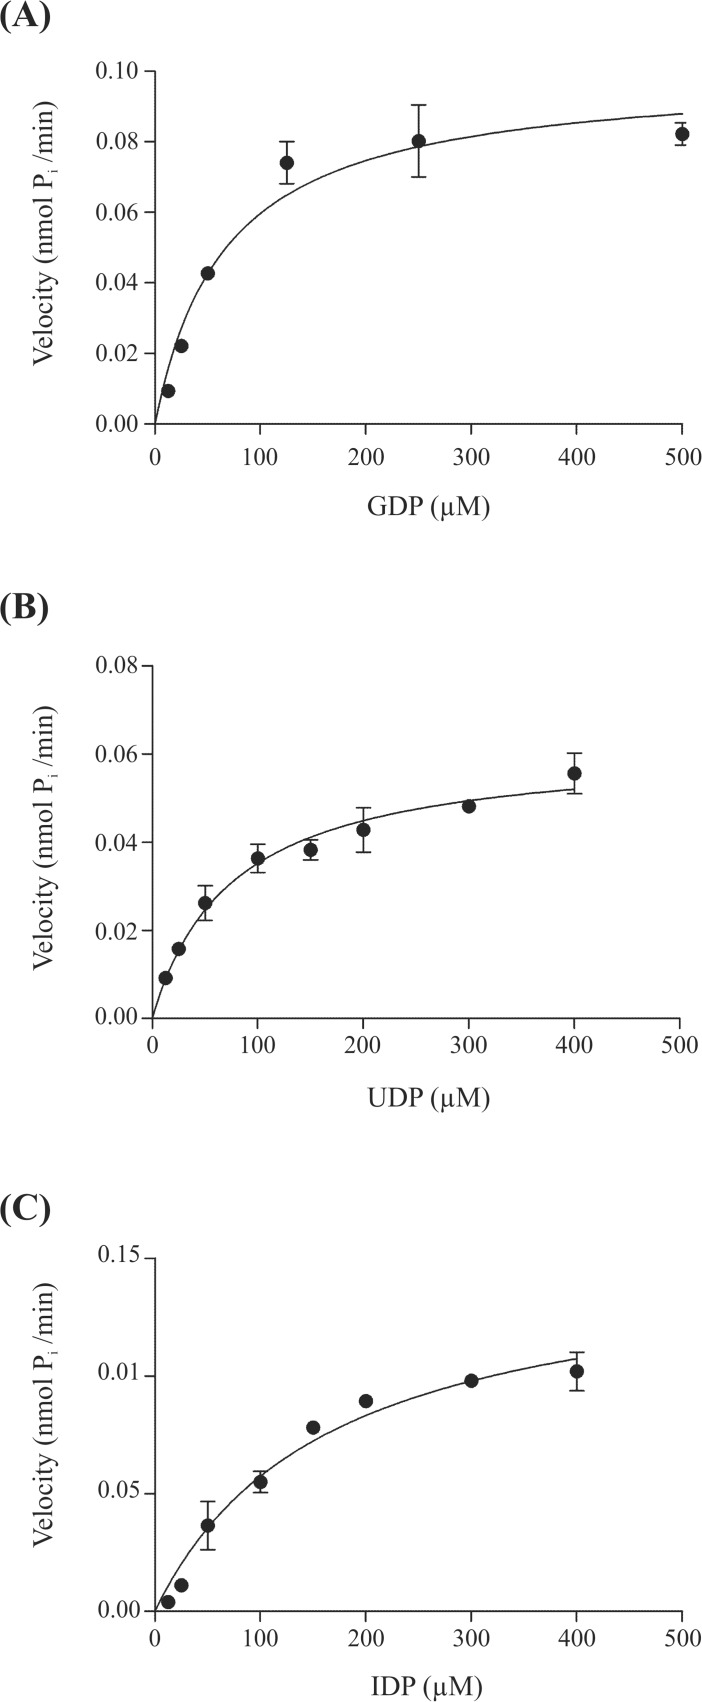
Km values of AtAPY1-GFP for GDP, UDP and IDP.Michaelis-Menten plots of the initial reaction velocities (v) for different concentrations of substrate are shown. Different amounts of AtAPY1-GFP enzyme were used in (A), (B) and (C) as a result of different starting material. The enzyme velocities were determined by the continuous assay. For each substrate concentration, the mean velocity calculated from two parallel reactions was plotted. The initial velocities were linear over time for ≥ 30 min. Each initial velocity was determined from a minimum of 24 data points from this linear phase. The error bars represent the standard deviations of the velocity means. The data set is representative of six (A, B) and three experiments (C), respectively.